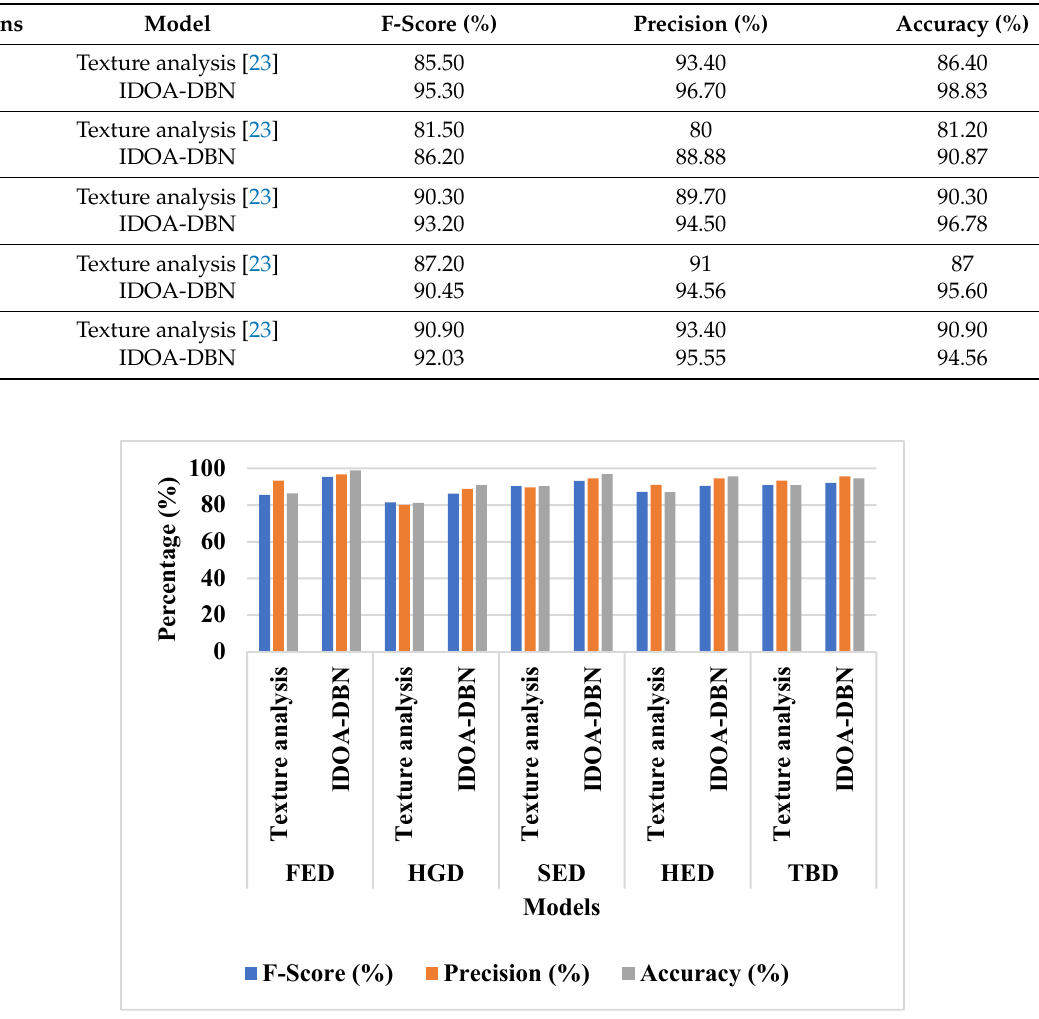
Figure 6. Graphical presentation of the various patch configurations with existing method.